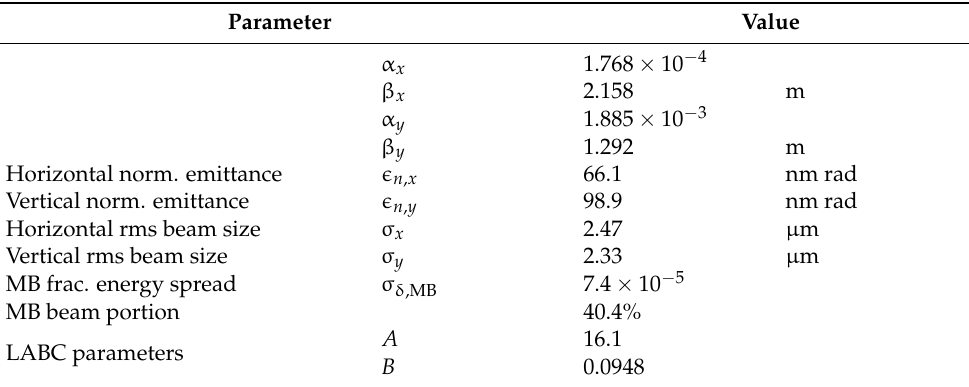
Table 9. Lattice 2 electron beam Twiss parameters and other properties at X-ray undulator entrance. Beam energy 12